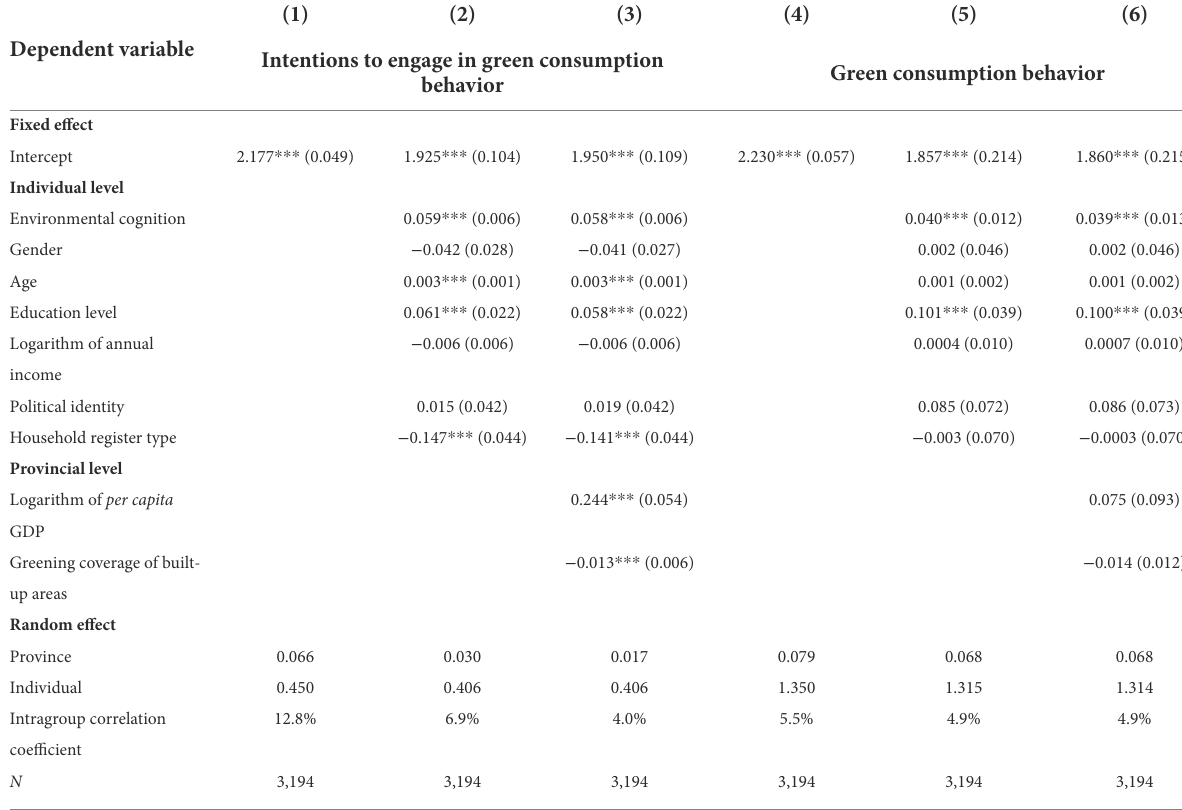
TABLE 4 Results of the multilayer linear model of the impact mechanism of green consumption based on the TPB